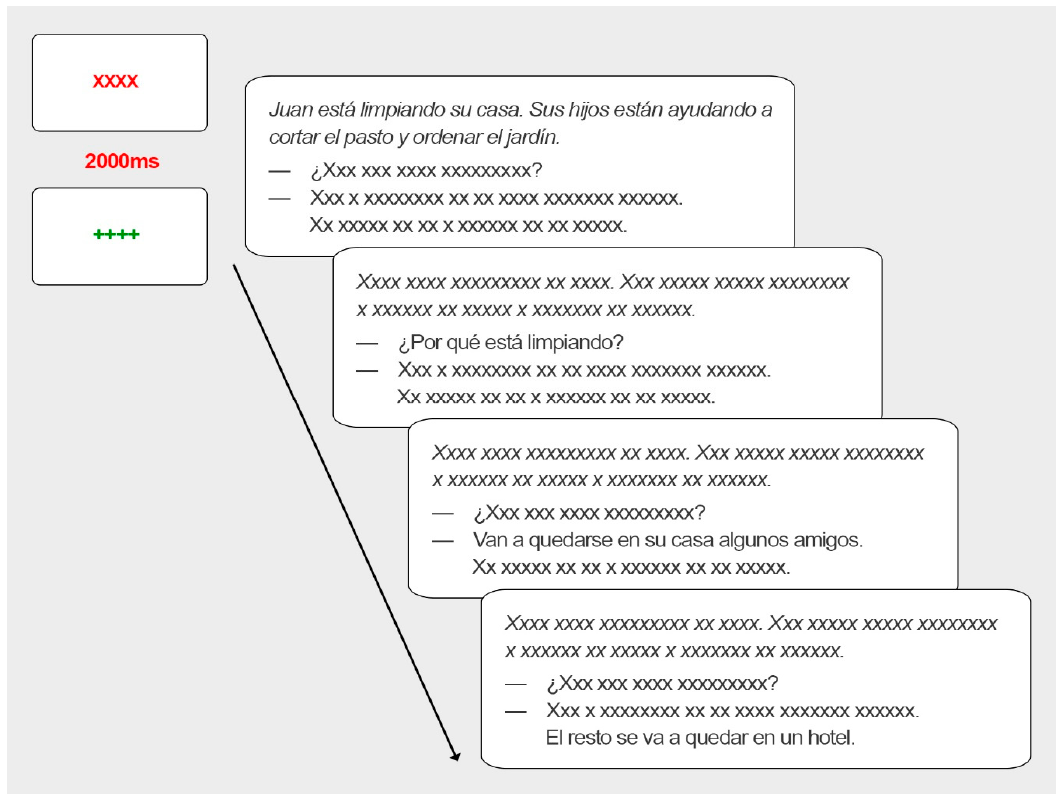
Figure 2. Procedure of experiment 2. Example of the screens that participants read during one item of the experiment.